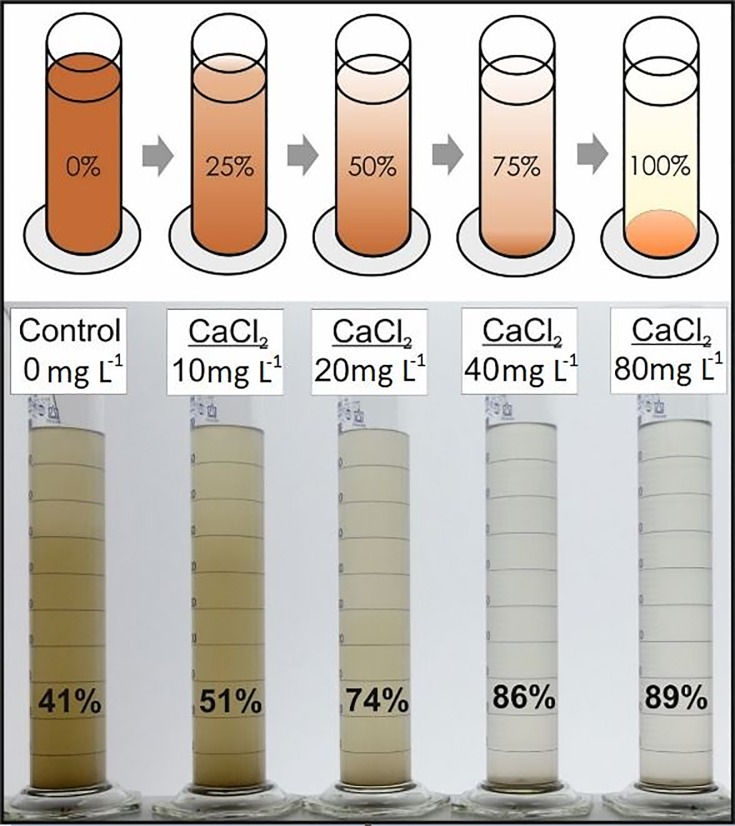
Top: Concept of differences in turbidity being an indicator of progress in sedimentation. Bottom: glass cylinders with 4 ion application rates of Ca in the form of CaCl2 and an ion-less control, after 3 hours.